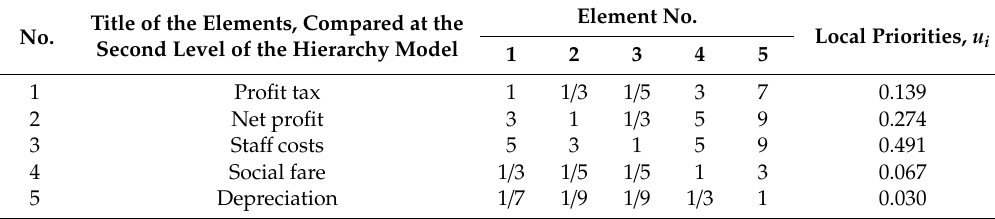
Table 5. Matrix of pairwise comparisons for elements of the second level of the hierarchical model for estimating the joint value of seaport industry